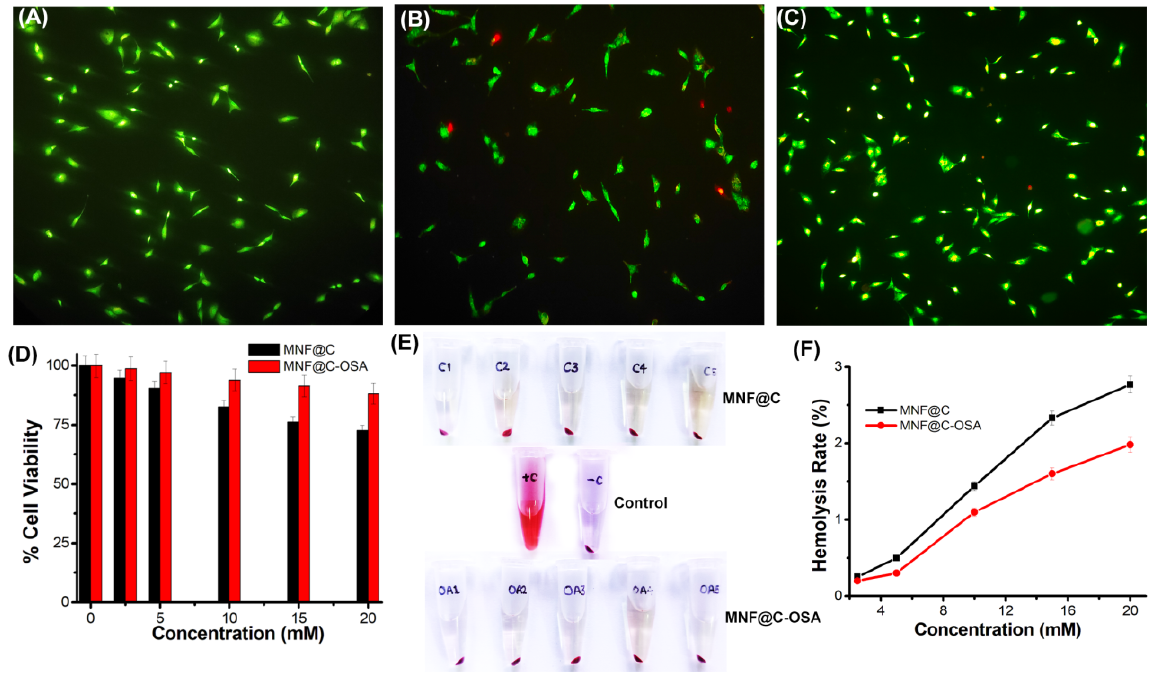
Figure 6. ( A ) Fluorescence microscopic image (10 × ) of A549 adenocarcinoma cells after staining with AO/EB. ( B ) AO/EB-stained A549 cells after treatment with 10 mM MNF@Cs. ( C ) AO/EB-stained